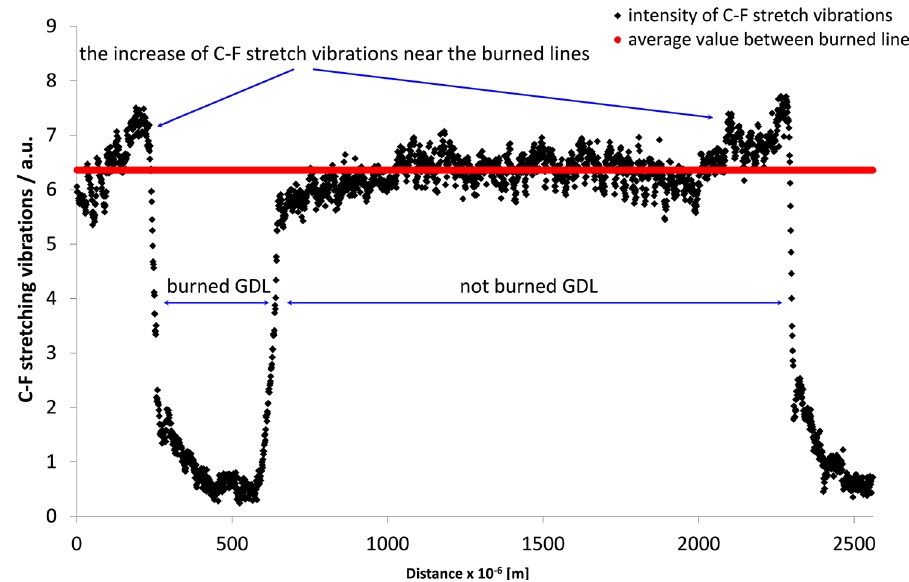
Fig. 3 FTIR line scan of the PTFE distribution measured between two lines of the laser pattern (see Fig. 1) in the MPL. Plotted is the integrated intensity of the CF 2 stretch vibrations (1100–1350 cm - 2 ) versus distance. The red line indicates the average CF 2 stretch vibration integrated intensity of non-modified